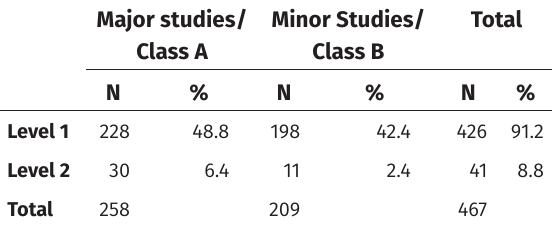
Table 8: Complexity of the rule depending on the level of education/socioeconomic stratum.